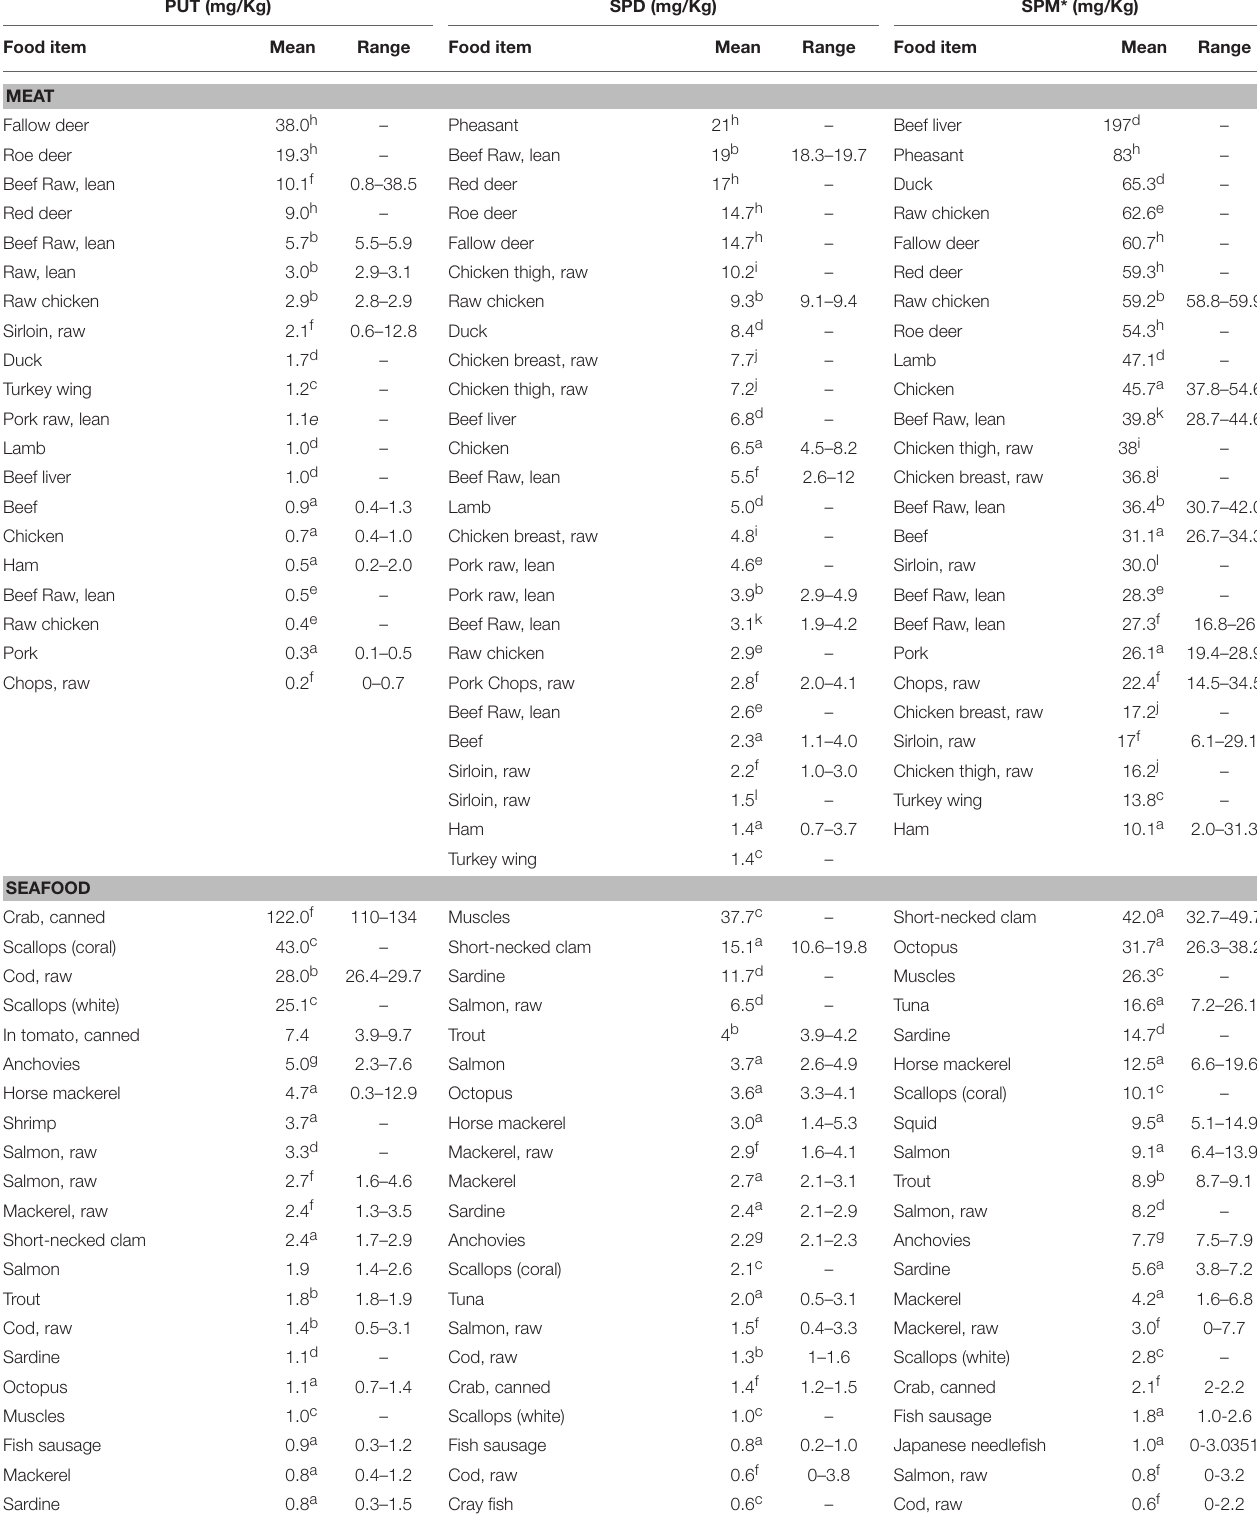
TABLE 2 | Polyamines content in meat, seafood, dairy, and other animal based